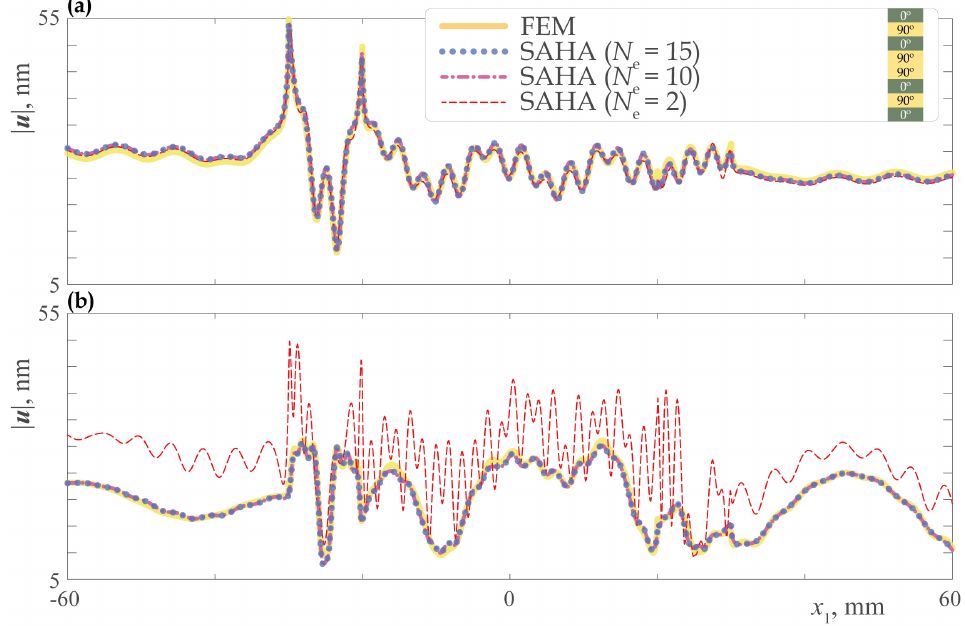
Figure 10. Displacement amplitudes | u | ( x 1 ,0 ) on the surface of multi-layered waveguide [ 0 ◦ ,90 ◦ ] 2s with an actuator and a sensor at frequencies f = 200 kHz ( a ) and f = 400 kHz ( b